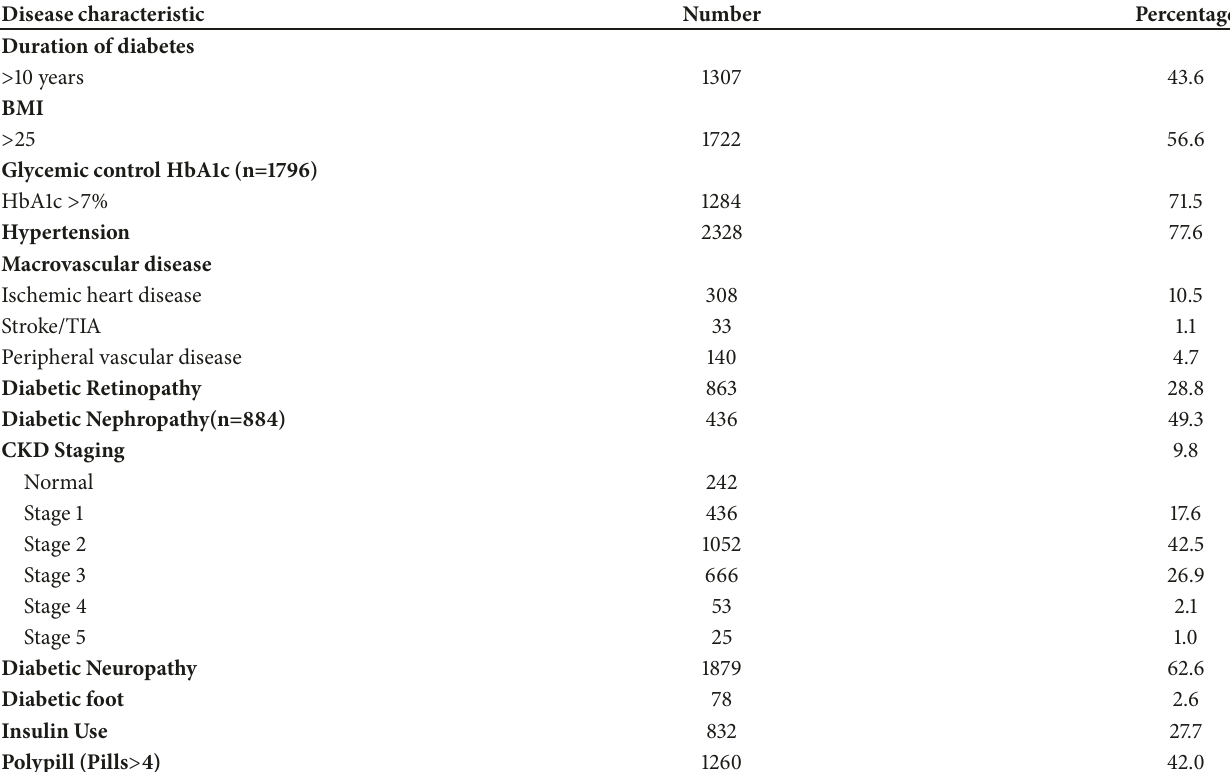
Table 2: Clinical health related indices of the patient